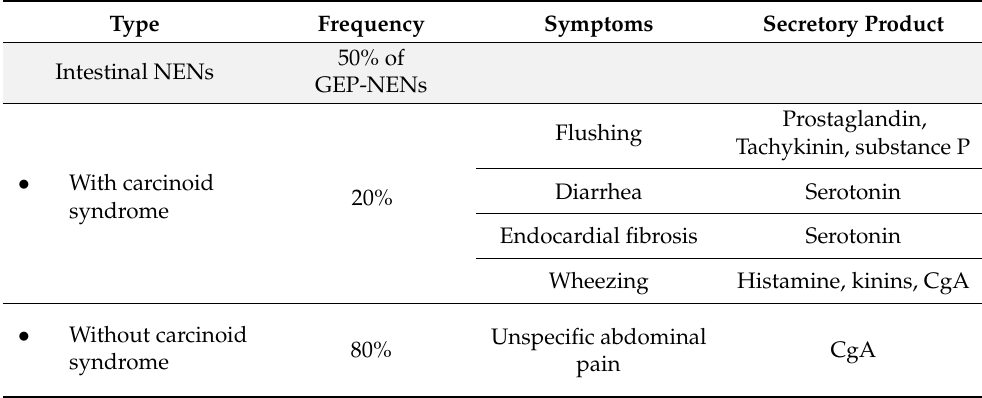
Table 2. Clinical presentation of GEP-NENs by site of origin and by hormone presentation